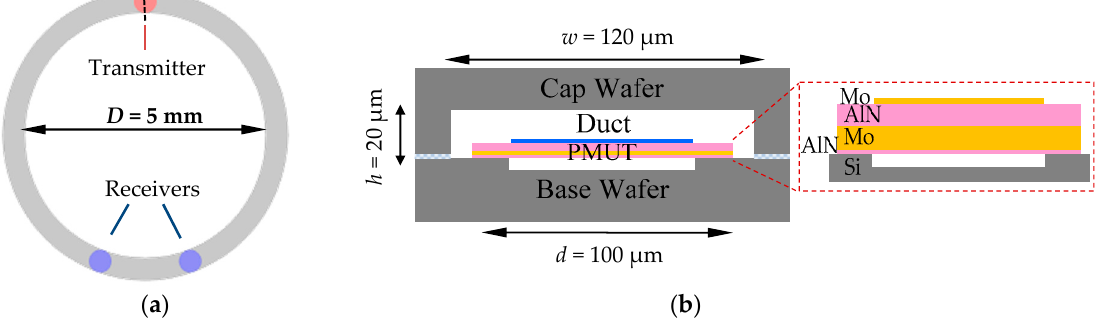
Figure 2. ( a ) Top-view schematic of the acoustic gyro (not in scale). In this specific case, three aluminum nitride piezoelectric micromachined ultrasonic transducers (AlN-PMUTs) are fabricated on the base wafer, one as a transmitter and two as receivers. The two receivers are placed symmetrically around the vertical axis. The circular trench on the cap wafer, once bonded to the base wafer, forms an enclosed air duct and bridges the three PMUTs. ( b ) Cross-sectional view across the center of the transmitter as marked by the dashed line in ( a ). The inset shows cross-section view of PMUT.